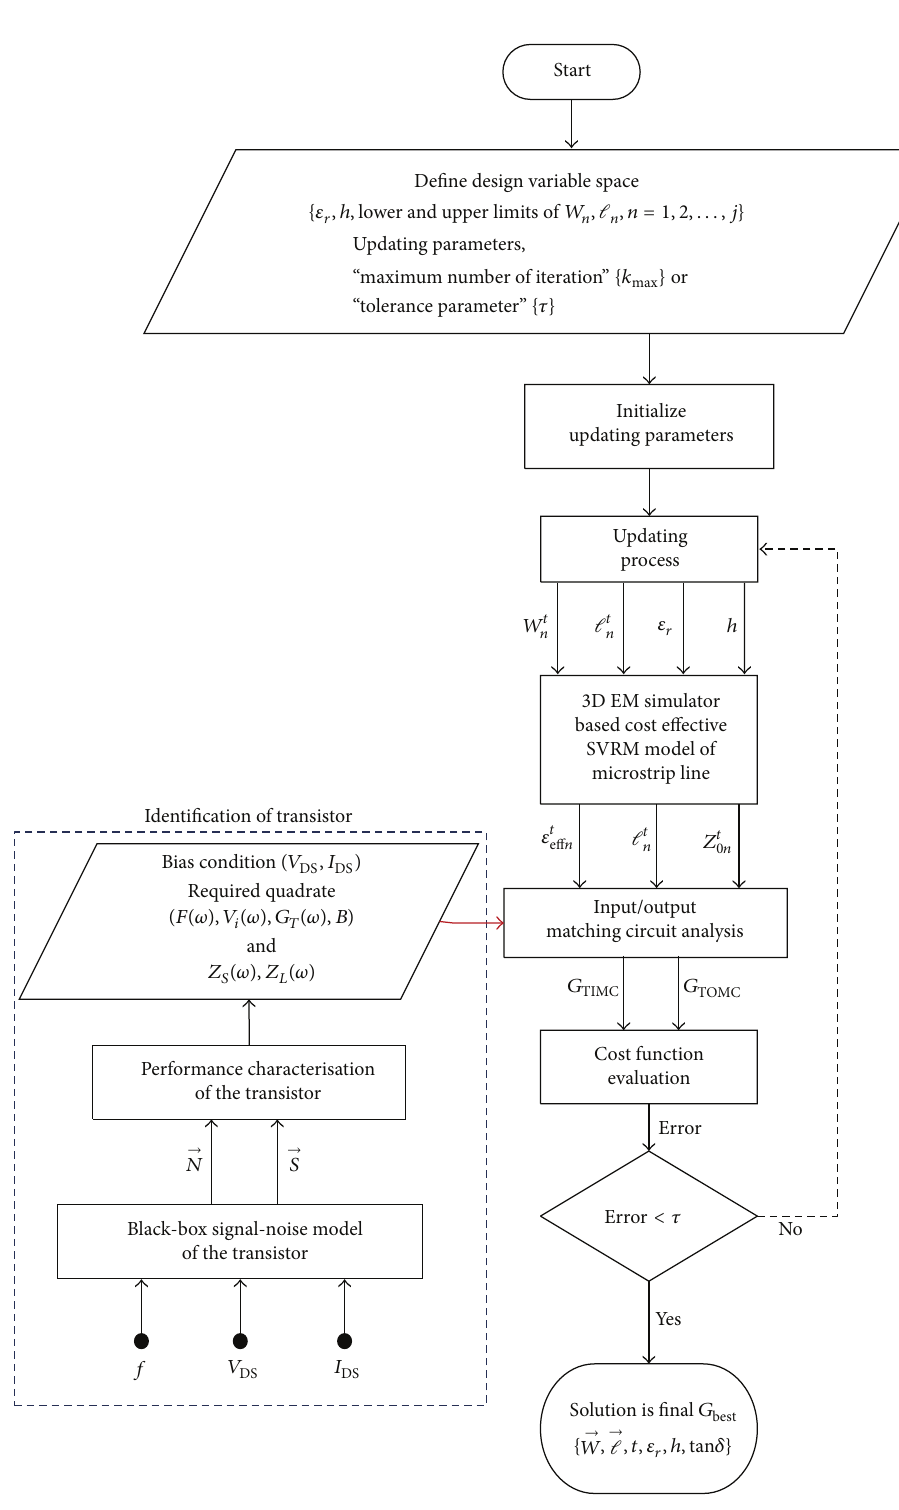
Figure 6: Block diagram of the performance characterisation-based design optimization of the matching circuits with the cost effective 3D EM-based Support Vector Microstrip